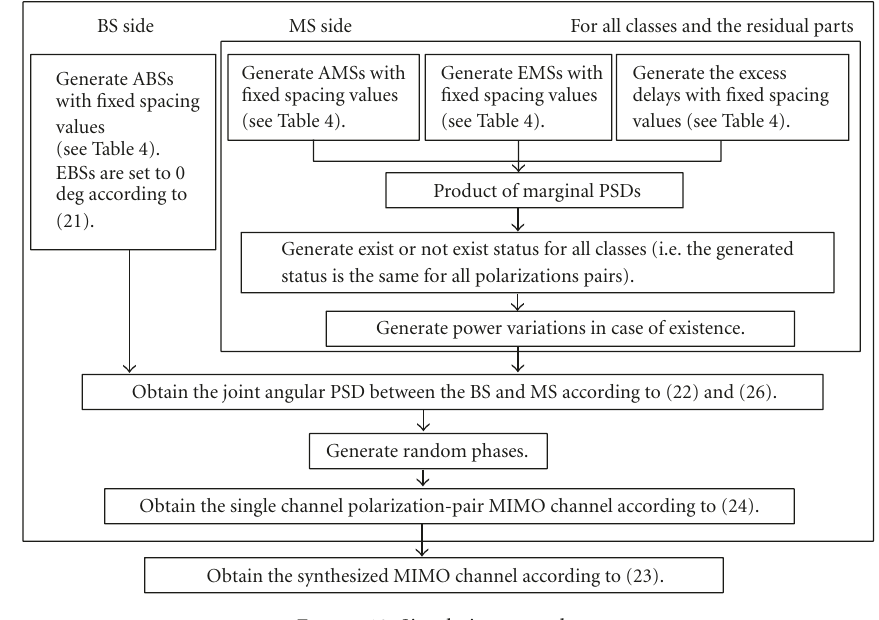
Figure 12: Simulation procedure.